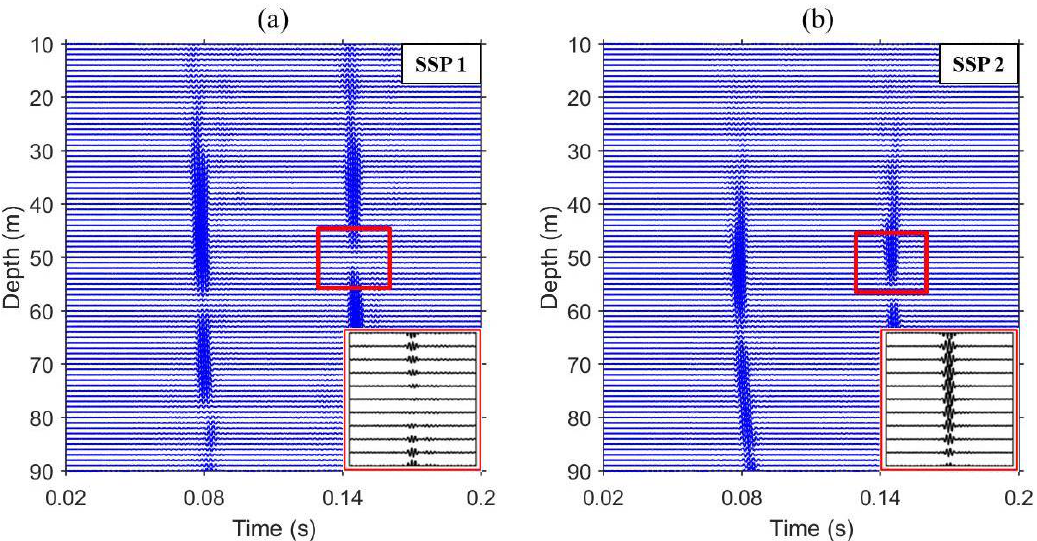
Figure 6. (Color online) Time series as a function of depth at a range of 2.3 km, which corresponds to Figure 5b. ( a ) For isovelocity SSP; ( b ) For downward-refracting SSP. The null location, denoted by a rectangular box, is magnified and the residual signal is highlighted at the bottom